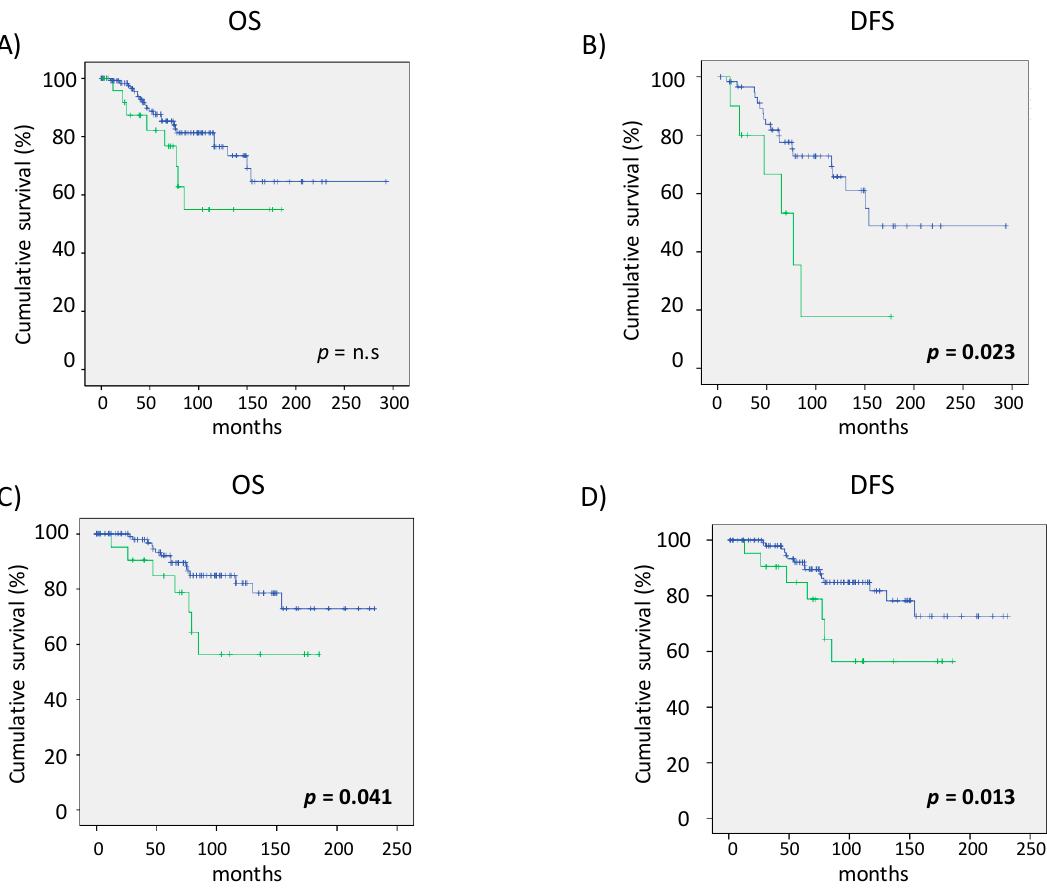
Figure 1. Association of the rs1449683 bFGF genotype with overall survival (OS) and disease free survival (DFS) in B-CLL patient groups. Kaplan–Meier curves according to the bFGF (T / -) genotype (green) versus other genotypes (C / C) (blue). ( A ) Overall survival (OS) and ( B ) disease free survival (DFS) in the global group of B-CLL patients (Log Rank Mantel-Cox p -value = n.s and p -value = 0.023, respectively), ( C ) OS and ( D ) DFS in patients with Binet A stage; p -value = 0.041; p -value = 0.013.